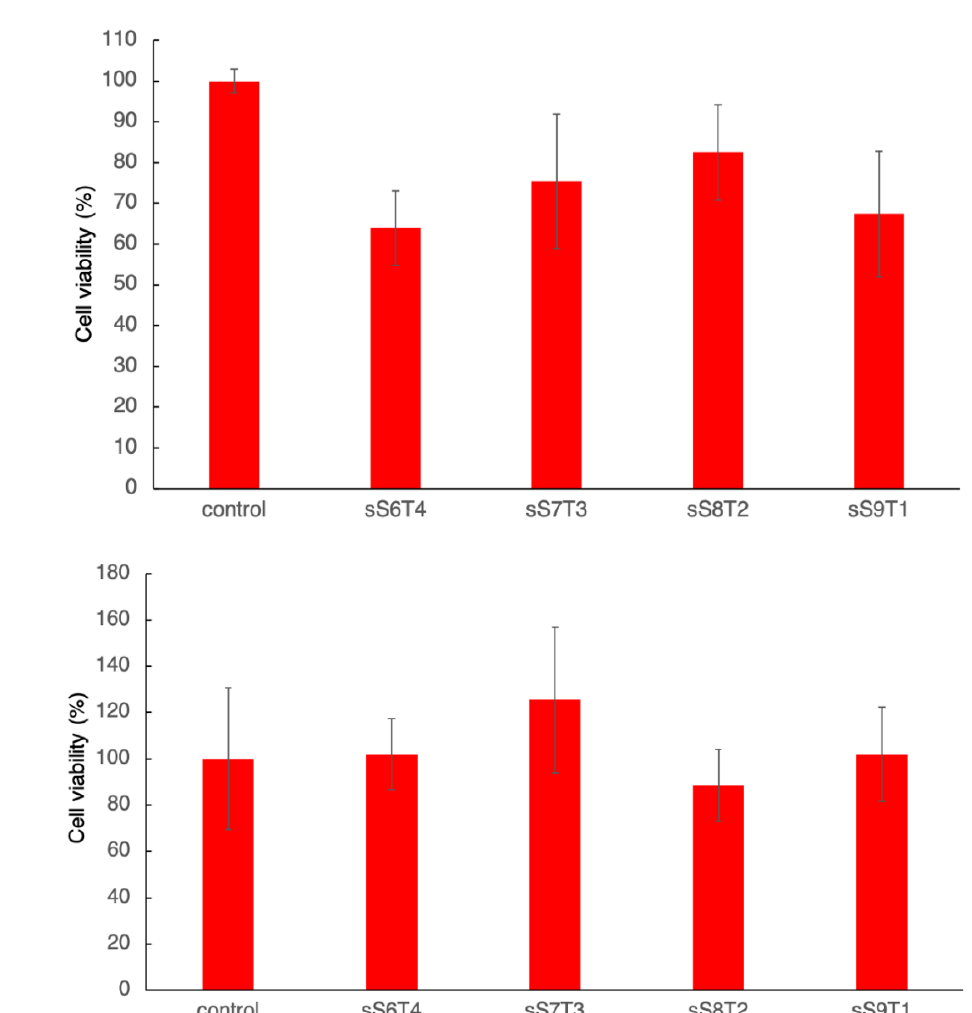
Figure 6. Cytotoxicity assay on different sulfonated copolymers by ( a ) the extracts and ( b ) direct contact. Polymers 2021 , 13 , x FOR PEER REVIEW